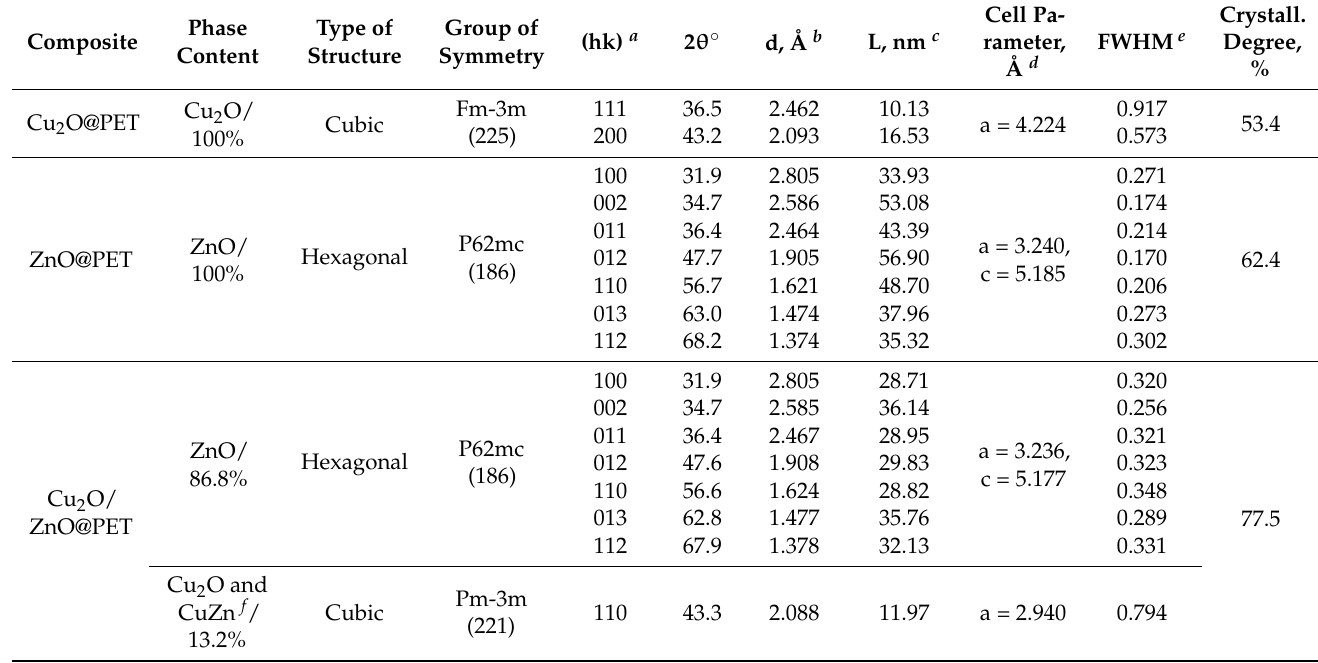
Figure 4. A schematic illustration of the synthesis of the Cu 2 O/ZnO@PET composite membrane based on the galvanic replacement reaction.